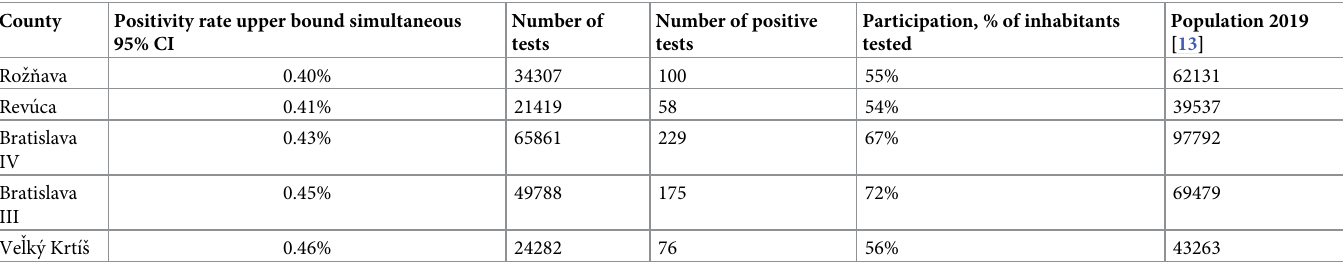
Table 1. The five counties with the lowest upper bound on the positivity rate of antigen tests.